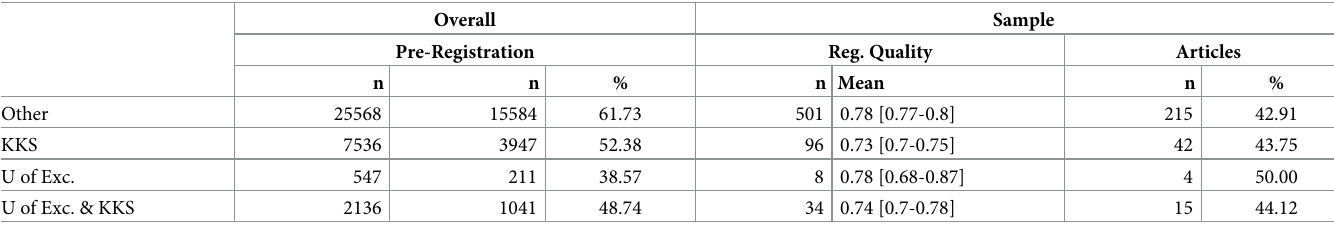
Table 3. Pre-Registration, registration quality with 95% confidence intervals and article availability in the overall database and in the manually inspected sample depending on structural